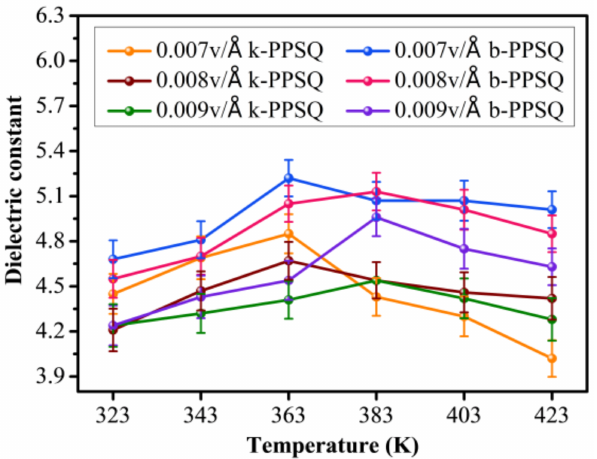
Figure 9. Dielectric constants of two models at different